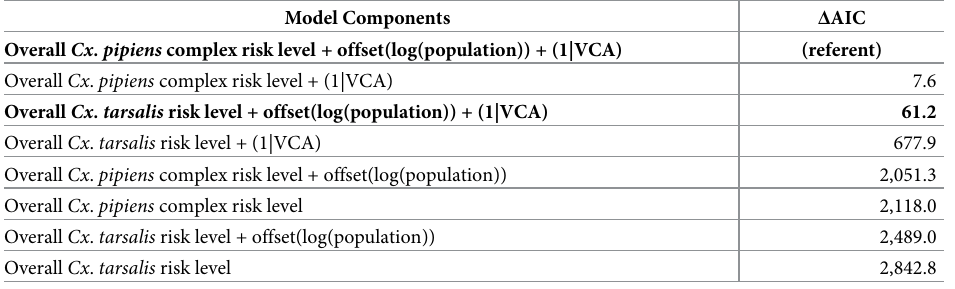
Table 2. Comparison of models that predict human WNV disease occurrence, CA, 2009–2018, ranked by Akaike Information Criterion (AIC). Lower AIC values indicate better